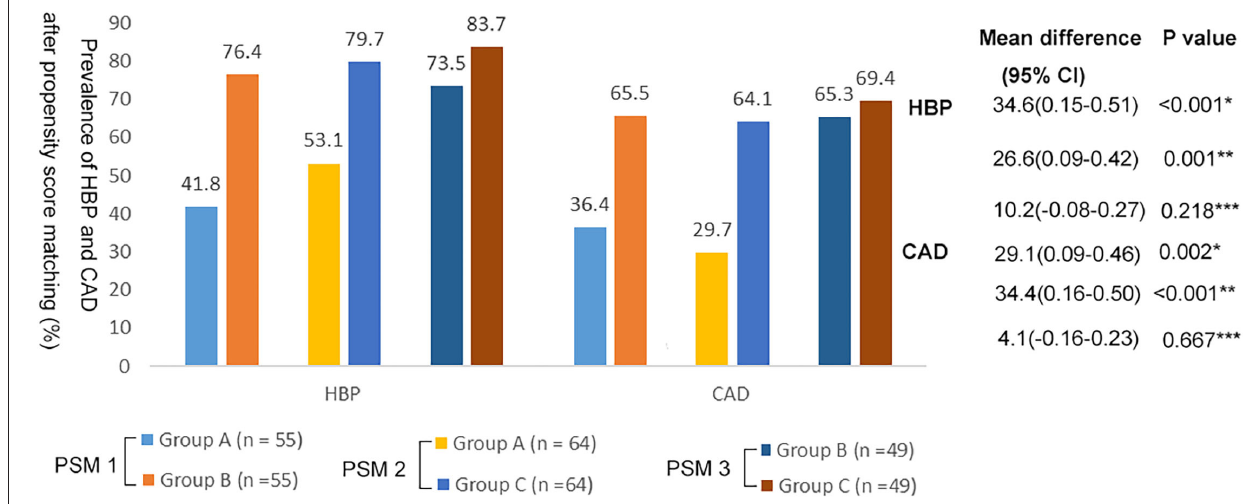
FIGURE 2 | Prevalence of HBP and CAD in the three groups after propensity score matching. *Group A vs. Group B; **Group A vs. Group C; ***Group B vs. Group